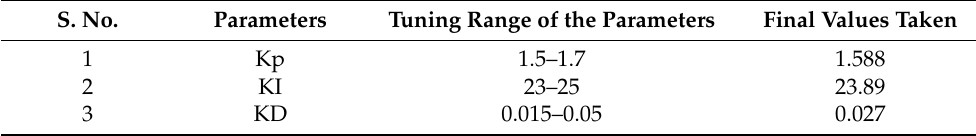
Table 2. Parameters of PID controller.